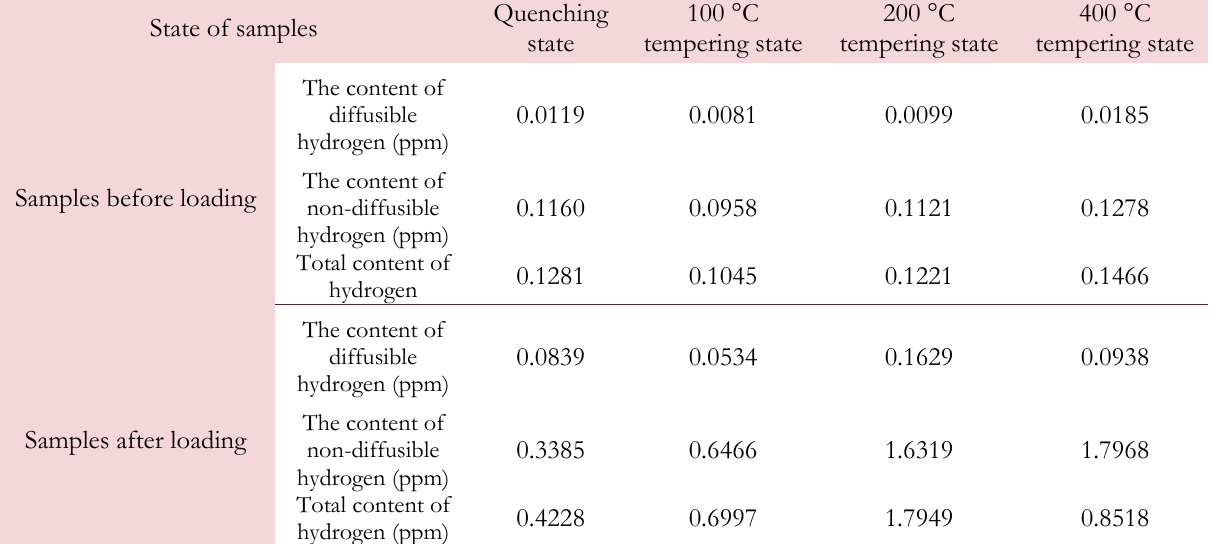
Table 4. The content of hydrogen of experimental materials in different states before and after loading (plate samples)